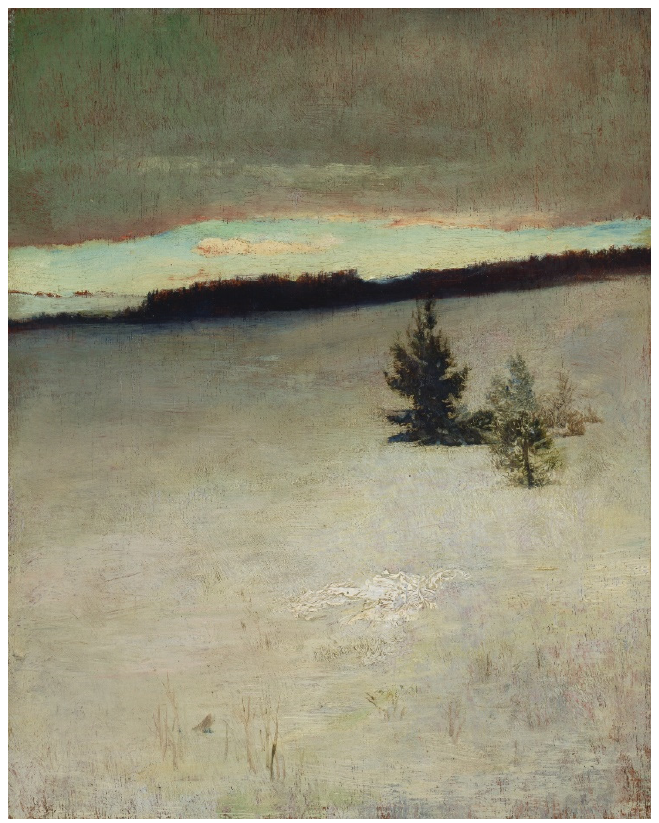
Figure 19. John La Farge, Snow Field, Morning, Roxbury , 1864, oil on beveled mahogany panel, 30.5 × 25.1 cm, Art Institute of Chicago. Purchased with funds provided by Mrs. Frank L. Sulzberger in memory of Mr. Frank L. Sulzberger.